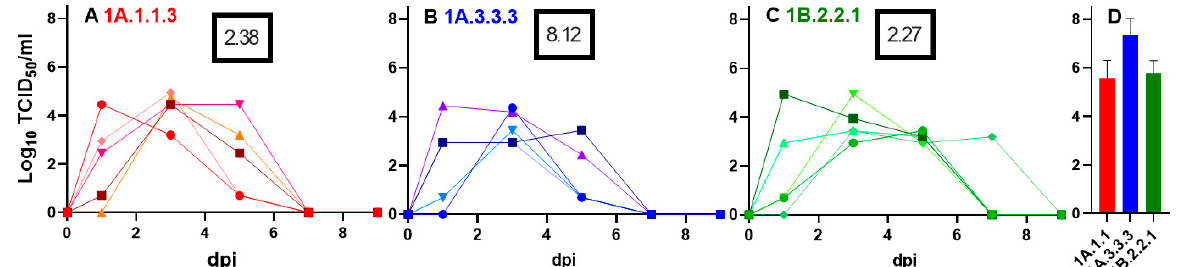
Figure 2. Shedding and replication of clade representative viruses in pigs. Individual pig nasal swabs (( A – C ), each line represents an individual pig) and group mean bronchoalveolar lavage fluid (BALF, n = 3) ( D ) viral load shown as log 10 TCID 50 /mL on MDCK cells. Number in the black box indicates the average (n = 3) percentage of lung surface with visible pneumonic lesions at the 5dpi necropsy.